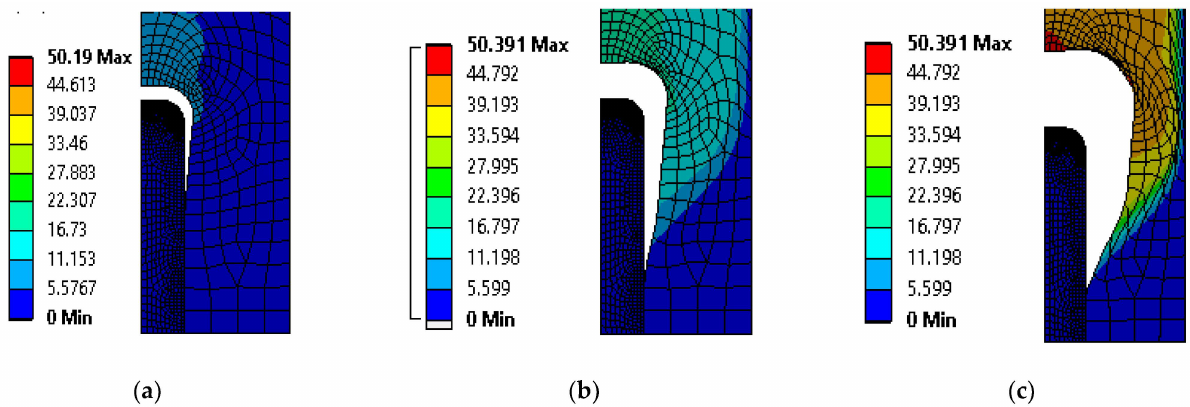
Figure 20. von Mises stress and displacement fields of the RVE of a PNC reinforced with an edge-curved clay nanoparticle: ( a ) crack initiates, ( b ) crack propagates, and ( c ) crack propagates to the final failure.